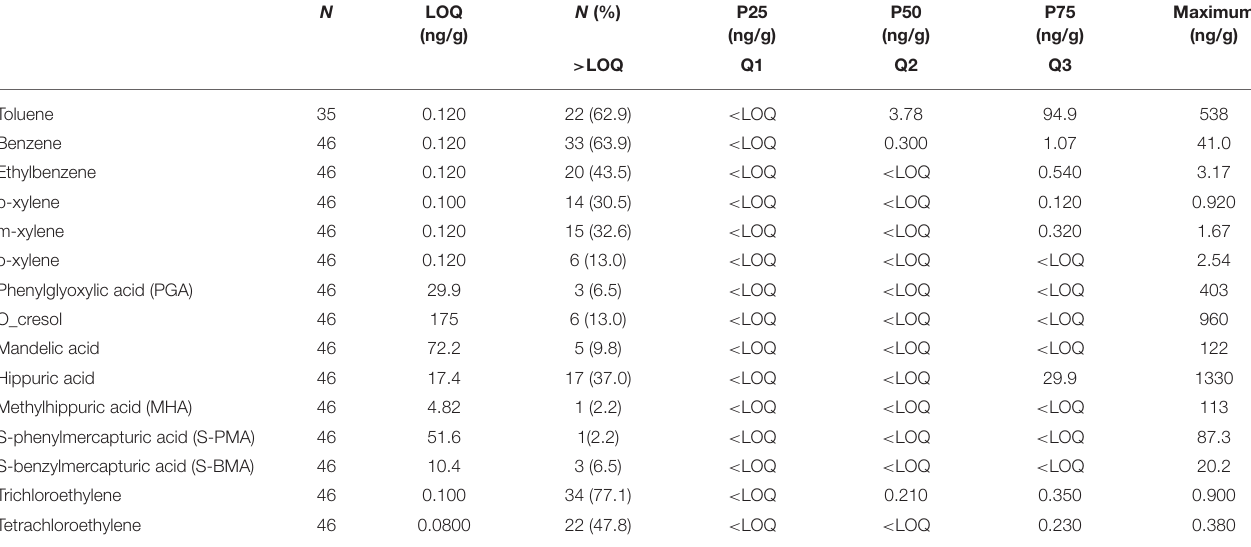
TABLE 2 | Distribution of chemical concentrations in meconium samples (BTEX and chlorinated solvents and metabolites) among controls ( n = 46).